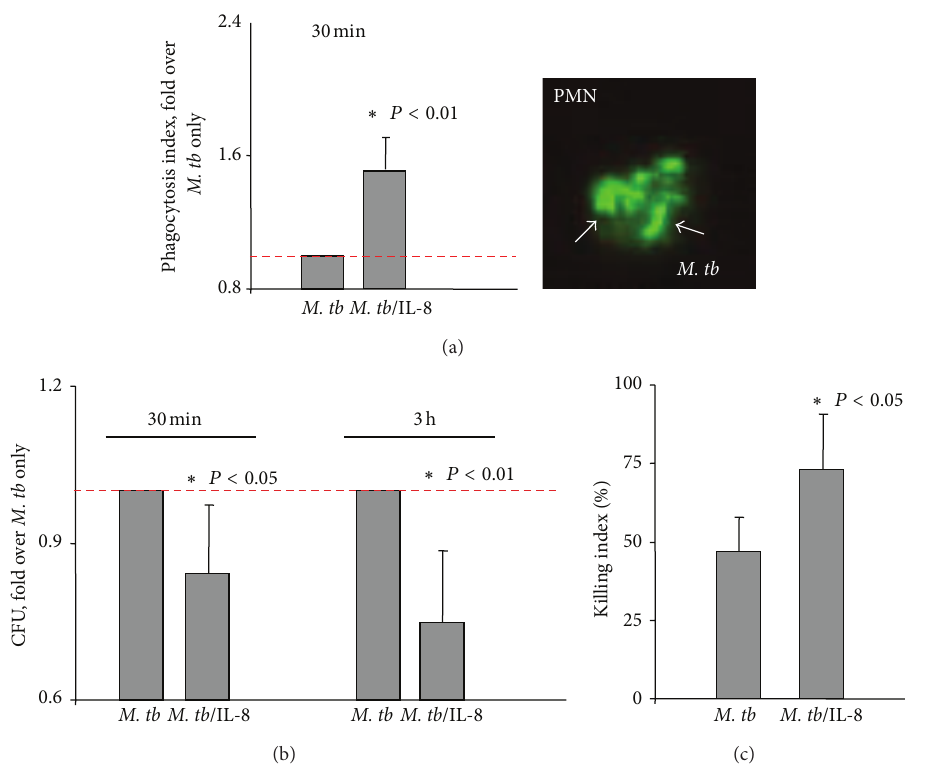
Figure 3: Effect of direct association of IL-8 with M. tb molecules on the ability of neutrophils to phagocytose and kill M. tb . (a) Phagocytosis of M. tb only ( M. tb ), or M. tb bound to IL-8 ( M. tb /IL-8) presented as a phagocytosis index/increase fold over M. tb only. Image of neutrophil phagocyting M. tb conjugated with FITC photographed under fluorescent microscope. (b) Phagocytosis and killing of M. tb only ( M. tb ), or M. tb associated with IL-8 ( M. tb /IL-8) calculated after 30 min and 3 h of infection using colony forming units (CFU) and presented as a CFU/fold over M. tb only. (c) Killing index ( % ) calculated for M. tb cytokine-free ( M. tb ) and M. tb associated with IL-8 ( M. tb /IL-8) according to the formula ([CFU at 30min − CFU at 3h] × 100/CFU at 30 min).